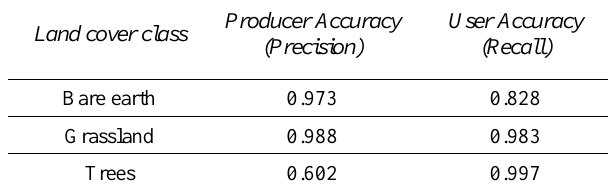
Table 2. Accuracy metrics for the RF land cover